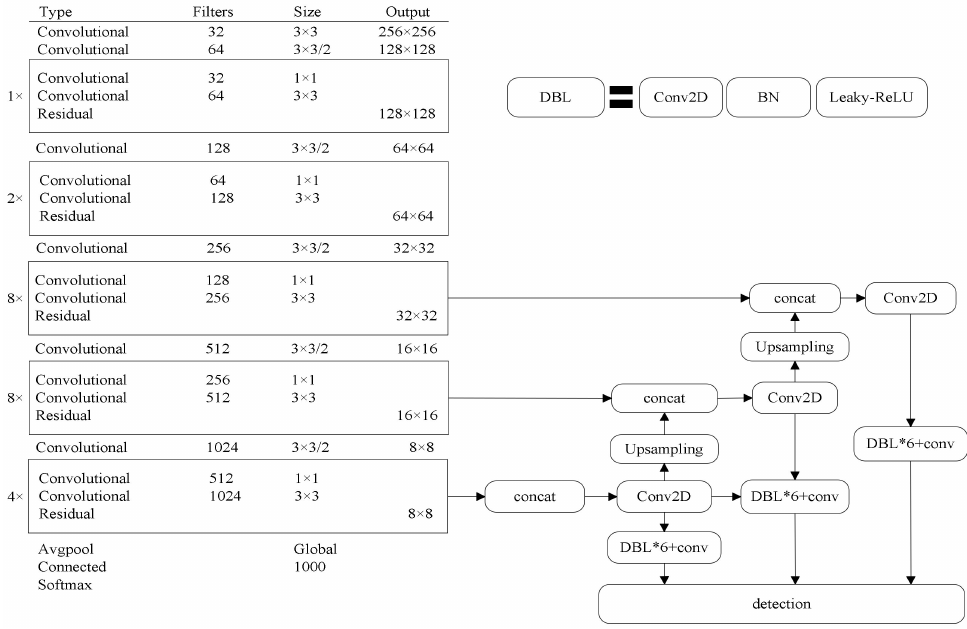
Figure 4. YOLOv3 network